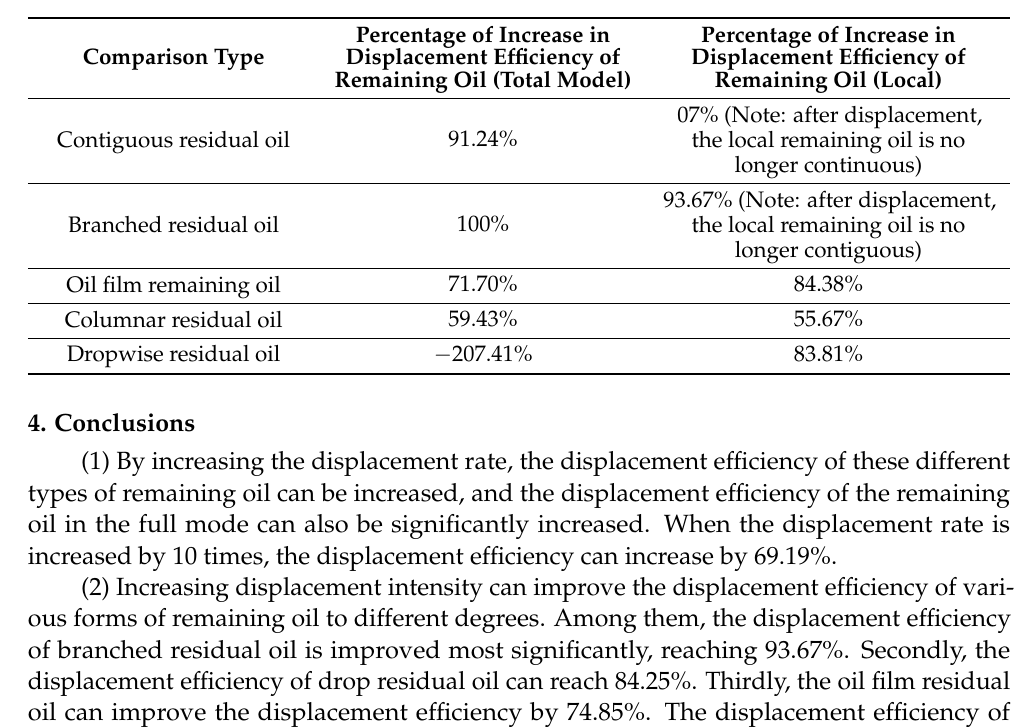
Table 6. Comparison data of displacement effect of whole remaining oil and local remaining